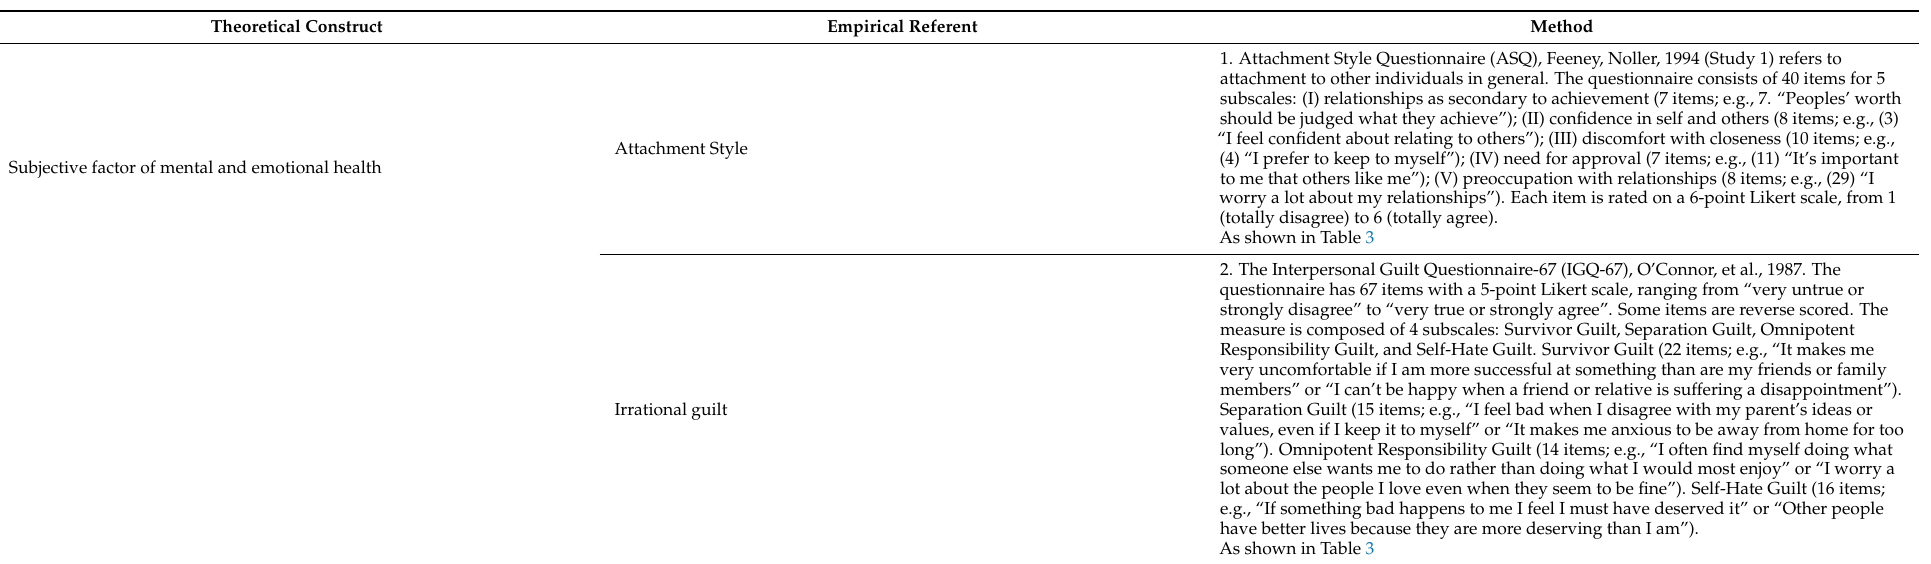
Table A2. Operationalization of theoretical constructs and psychodiagnostic scales/methods in Study 1 and Study